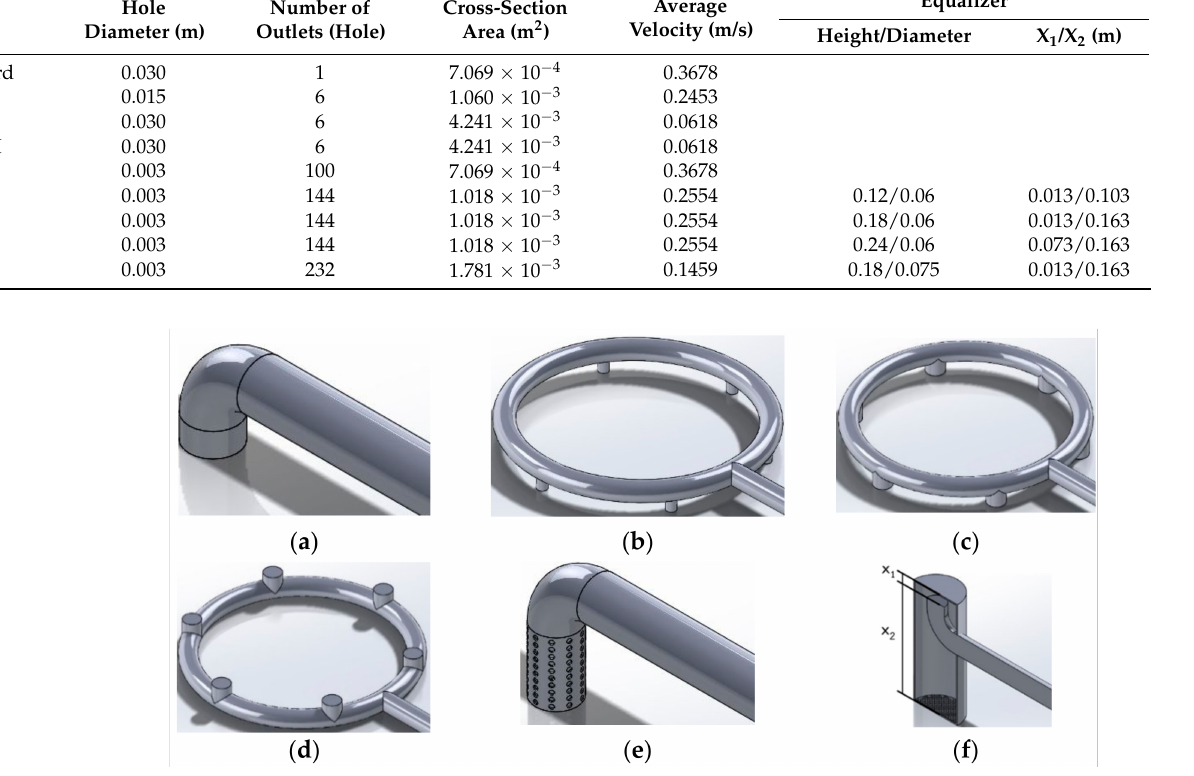
Figure 3. The geometries of the modified inlet pipes: ( a ) Direct downward model; ( b ) Annular inlet I model; ( c ) Annular inlet II model; ( d ) Annular inlet III model; ( e ) Perforated pipe model; ( f ) Equalizer I-IV